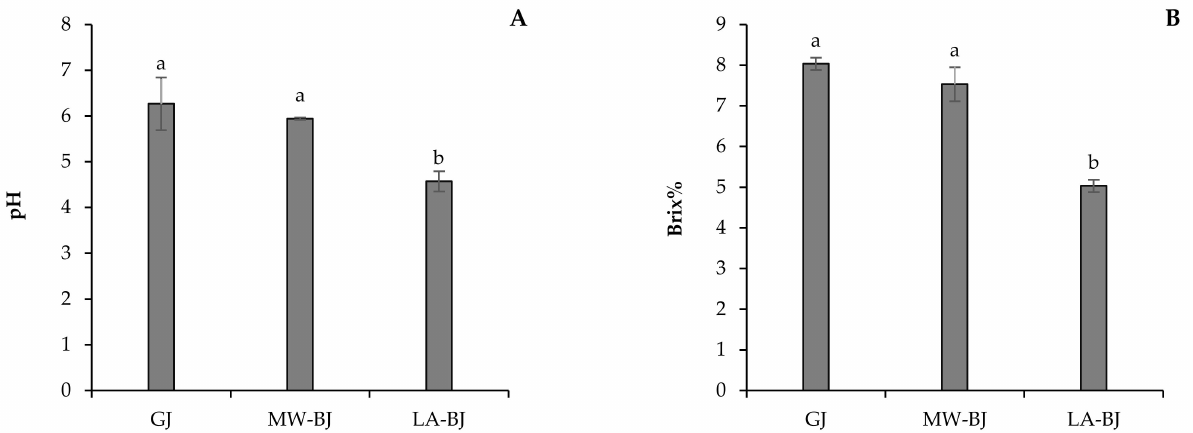
Figure 4. ( A ) pH and ( B ) Brix value (%) of the liquid fractions obtained after the processing of the broccoli fresh green leaves by different fractionation methods. GJ is the fresh green liquid obtained after the mechanical pressing of the fresh green leaves of broccoli, MW-BJ is the brown liquid obtained after the thermal treatment of the fresh GJ to isolate the leaf protein using a microwave device, and LA-BJ is the brown liquid obtained after the lacto-fermentation of the fresh GJ to isolate the leaf protein. Different letters on the columns show significant differences according to Tukey’s test at the level of p ≤ 0.05. Data are presented as mean ± SD ( n =